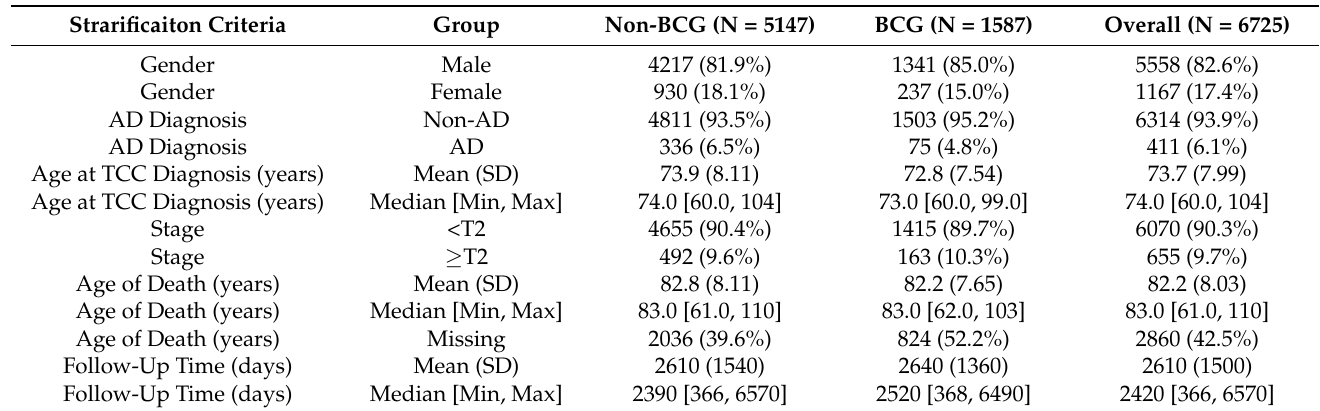
Table 1. Characteristics of patients in the CHS